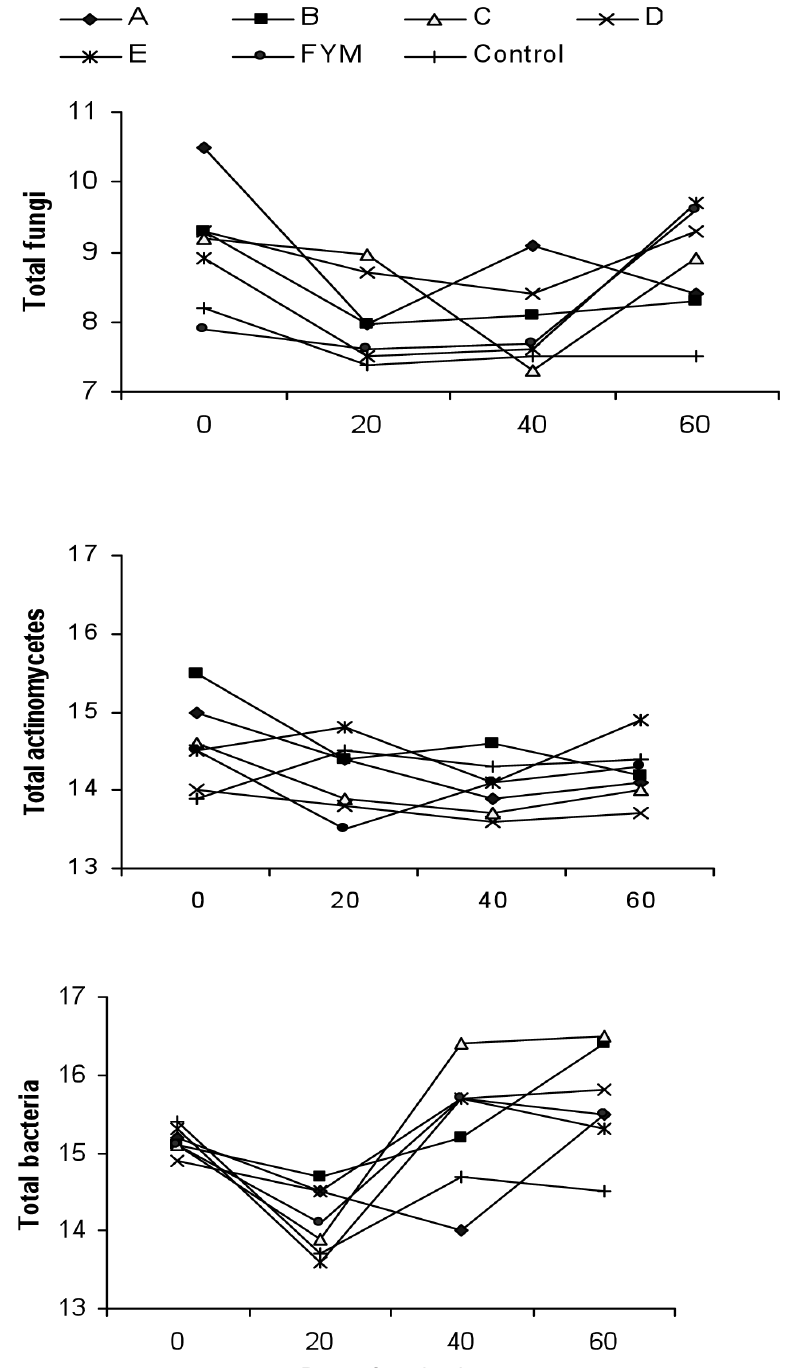
Figure 1. Influence of compost amendments on total fungi, actinomycetes and bacterial population (log at 30 cm soil depth in cowpea planted plots in 2001. [A, Calotropis procera ; B, Prosopis juliflora ; C, weeds; D, Azadi- rachta indica and E, Acacia nilotica ]. LSD ( P =0.05) of treatment (fungi, 0.31; actinomycetes, 0.12; bacteria, 0.09) and interval (fungi. 0.23; actinomycetes, 0.09; bacteria,